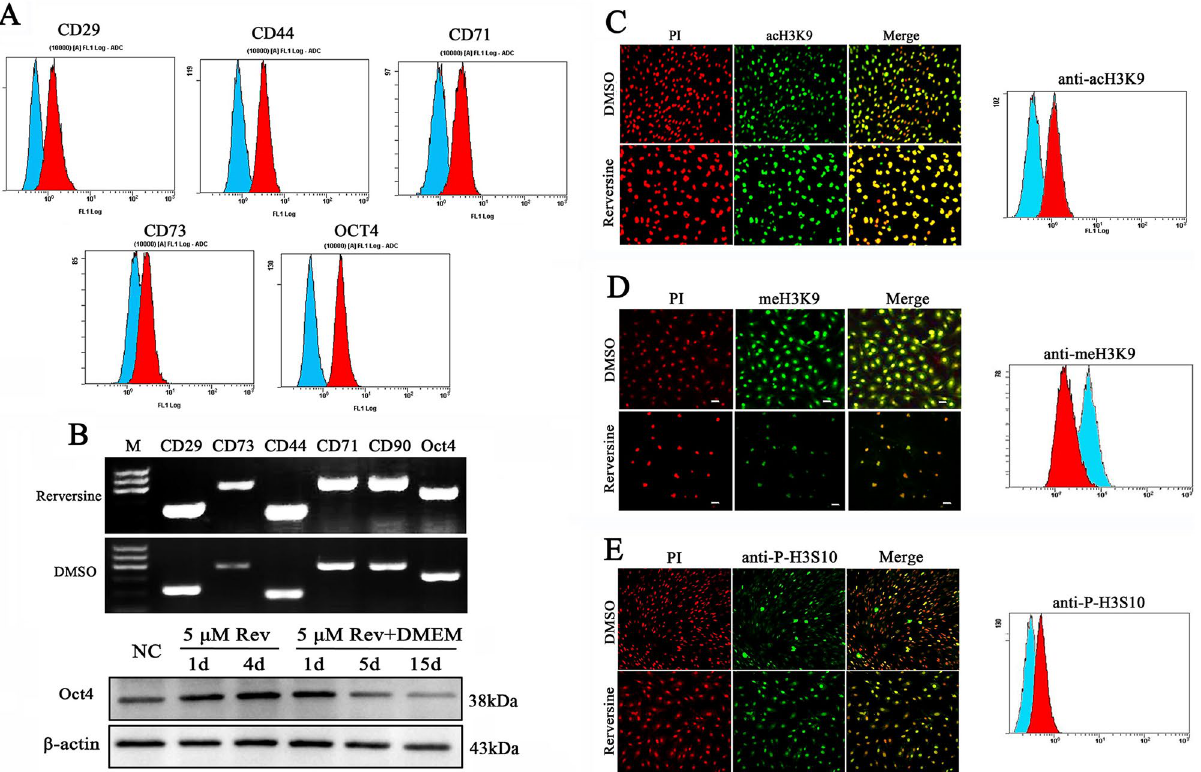
Figure 7. Reversine promoted the expression of pluripotent and mesenchymal markers and epigenetic modification. ( A ) The expression of mesenchymal stem cell markers CD29, CD44, CD71, CD73, and pluripotent marker Oct4 were analyzed by flow cytometry. ( B ) RT-PCR and qRT-PCR were used to examine mRNA expression levels of CD29, CD44, CD71, CD73, CD90 and Oct4. ( C – E ) The level of histone acetylation of acH3K9, histone methylatin of meH3K9, and histone phosphorylation of p-H3H10 were analyzed by immunocytochemistry and flow cytometry. PI, Red; anti-acH3K9, anti-meH3K9 and anti-p-H3H10 immunofluorescent,